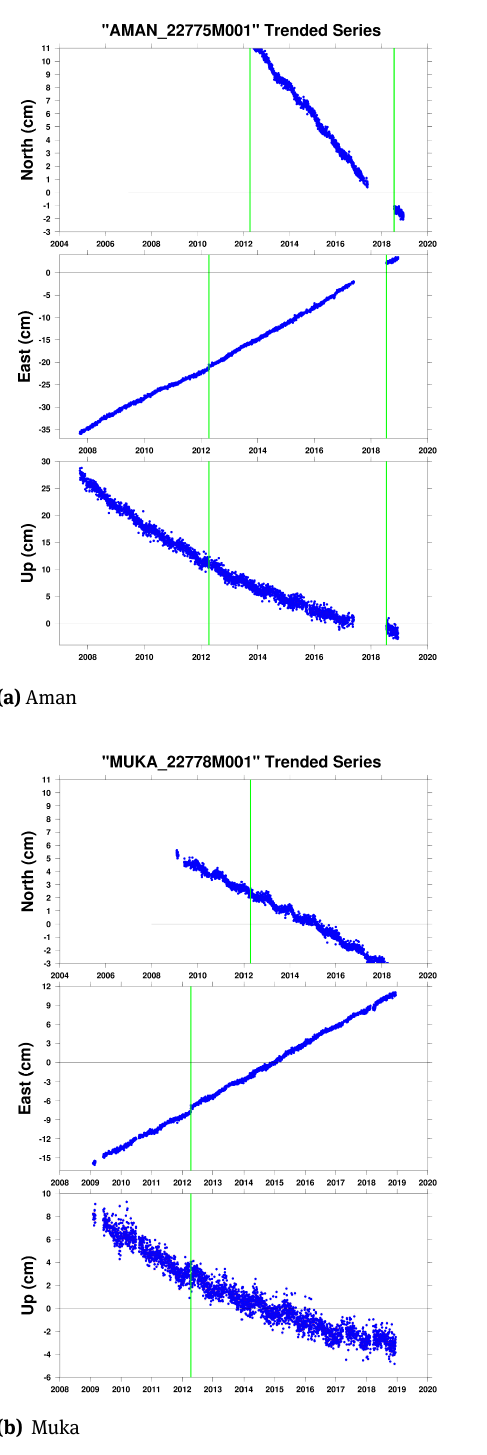
Fig. 9. Vertical time-series at (a) AMAN and (b) MUKA